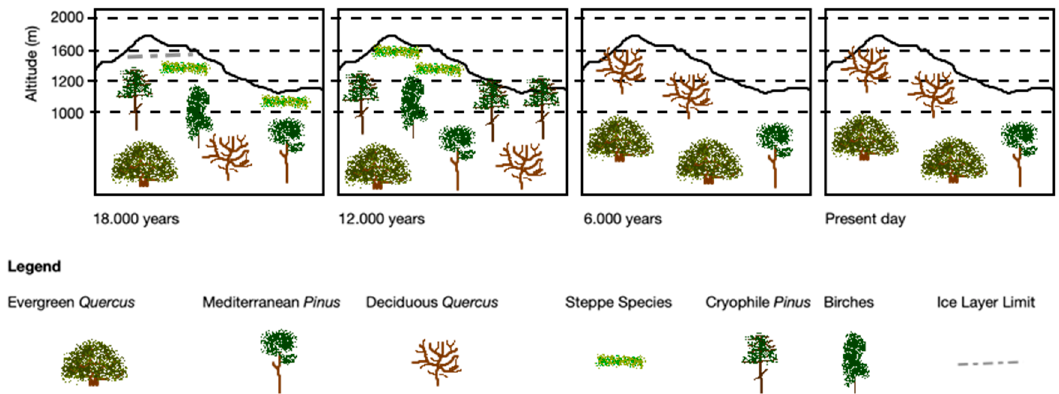
Figure 4. Evolution of pine forests and other woody formations since the last glacial maximum in the different bands of Serra da Estrela (adapted from [55] ).